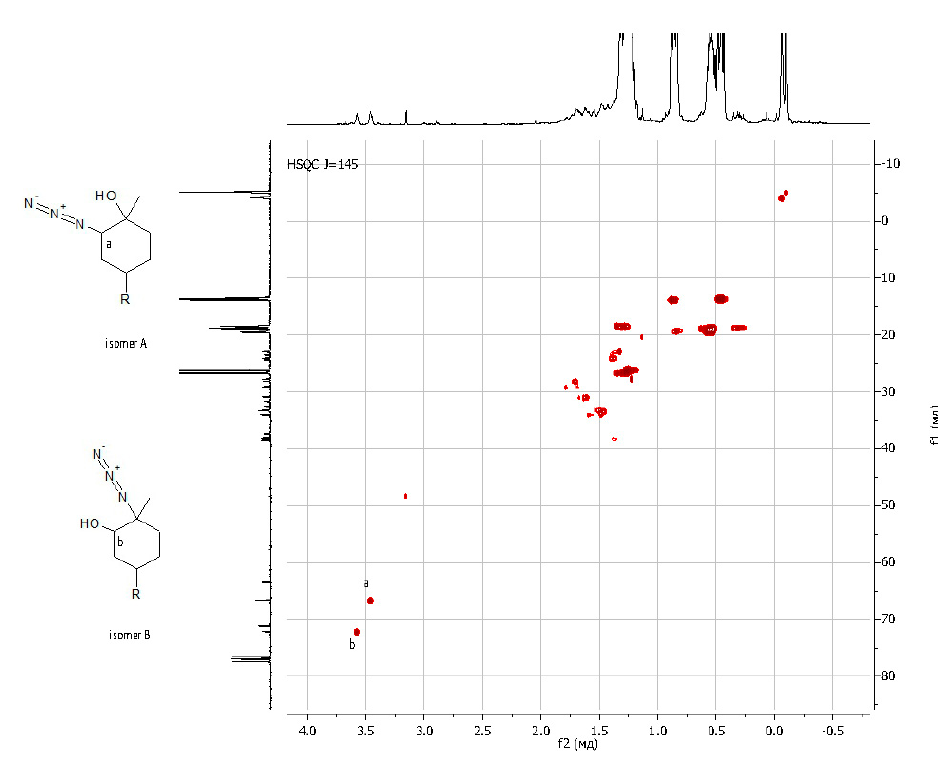
Appl. Sci. 2023 , 11 , x Figure 3. APT NMR spectrum of LimN 3 -G 1 Bu 4 . Figure 3. APT NMR spectrum of LimN 3 -G 1 Bu